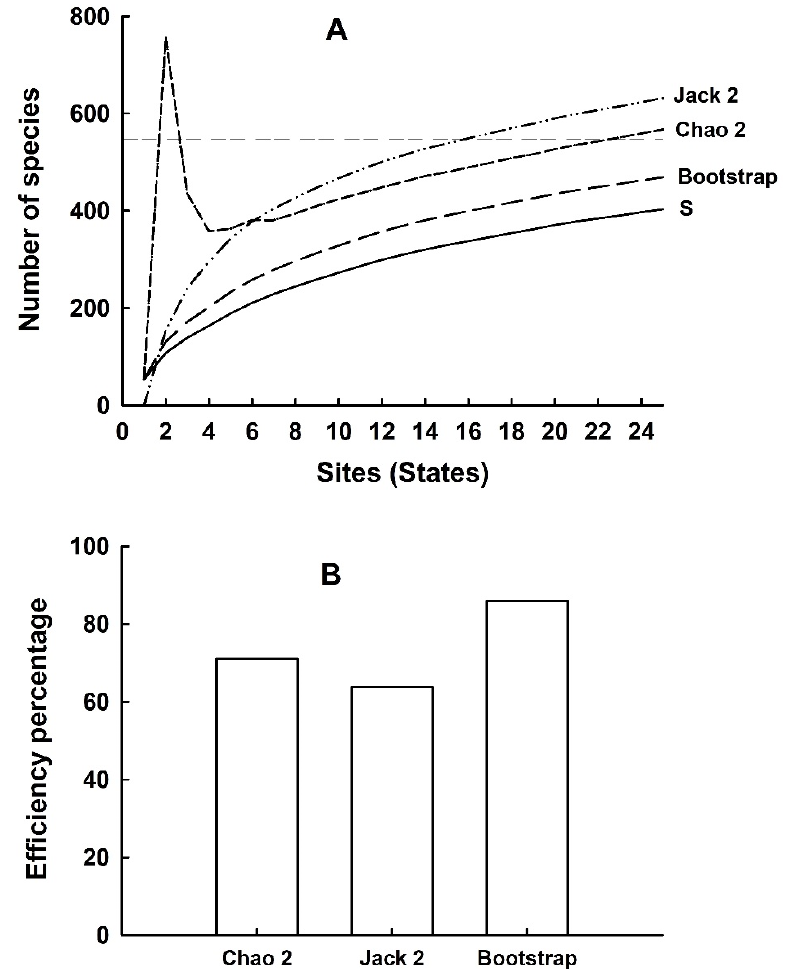
Figure 1. Diversity estimators ( A ) and efficiency percentage ( B ) using Jack 2, Chao 2, and Bootstrap methods.